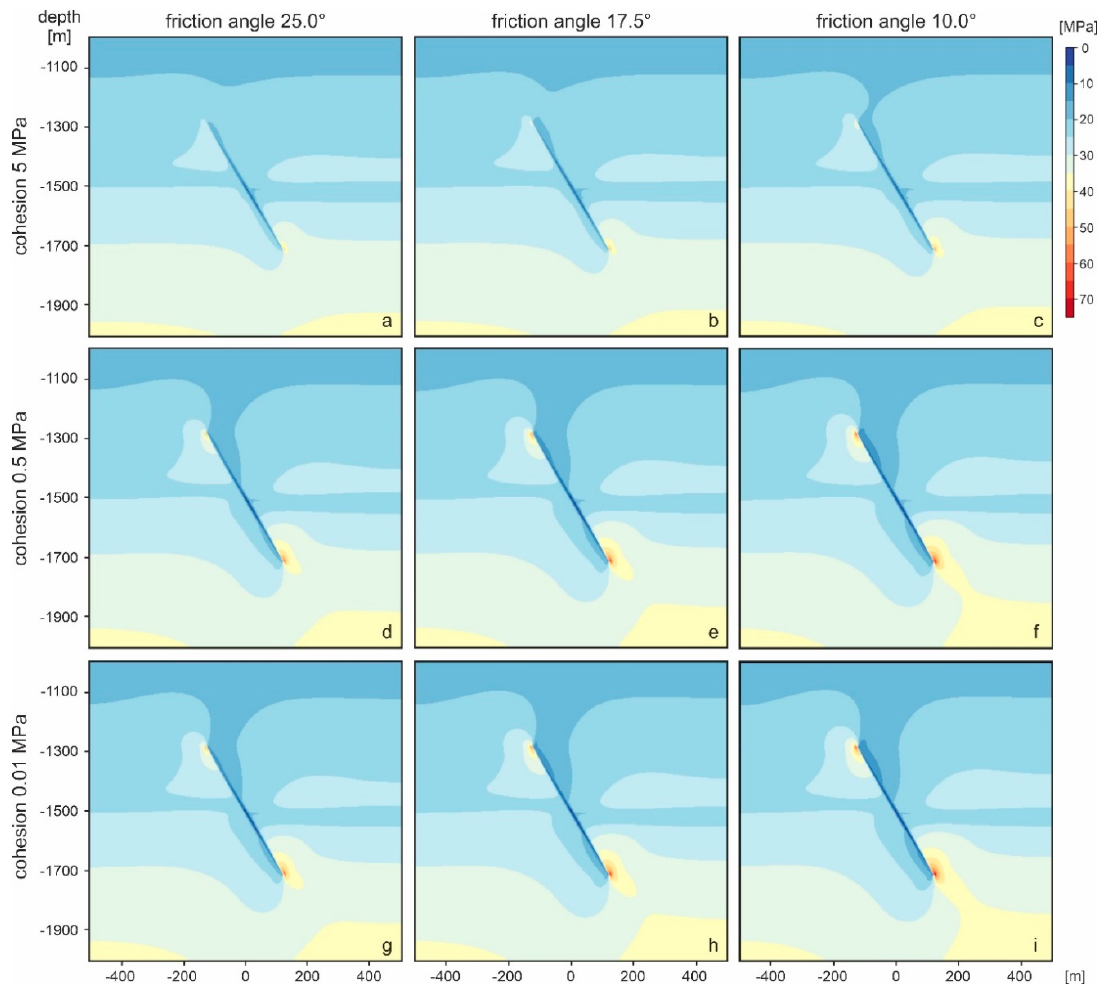
Figure 14. Spatial variation in the magnitude of the effective maximum principal stress (S 1,eff ) after five years of injection for three different cohesion values and three different friction angles assigned to the fault zone rocks. The cohesion is varied from top to bottom row ( a , d , g ; b , e , h ; c , f , i ) and the friction angle is varied from left to right ( a–c , d–f , g–i ).